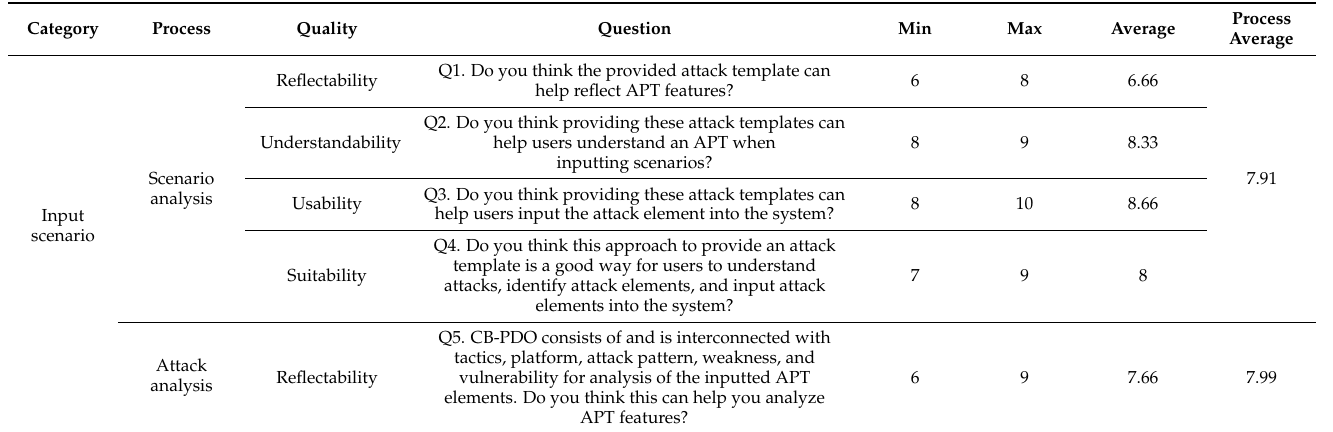
Table 8. Components of and responses to the